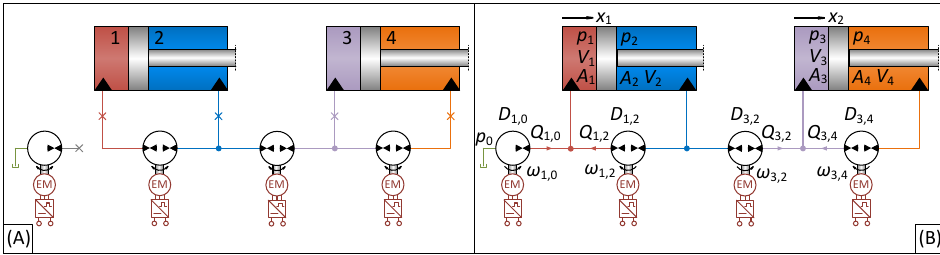
Figure 11. ( A ) Example of interconnection scheme for linear VDN topology; ( B ) specific interconnec- tion scheme 1 ↔ 2 ↔ 3 ↔ 4, 0 ↔ 1 for linear VDN topology.